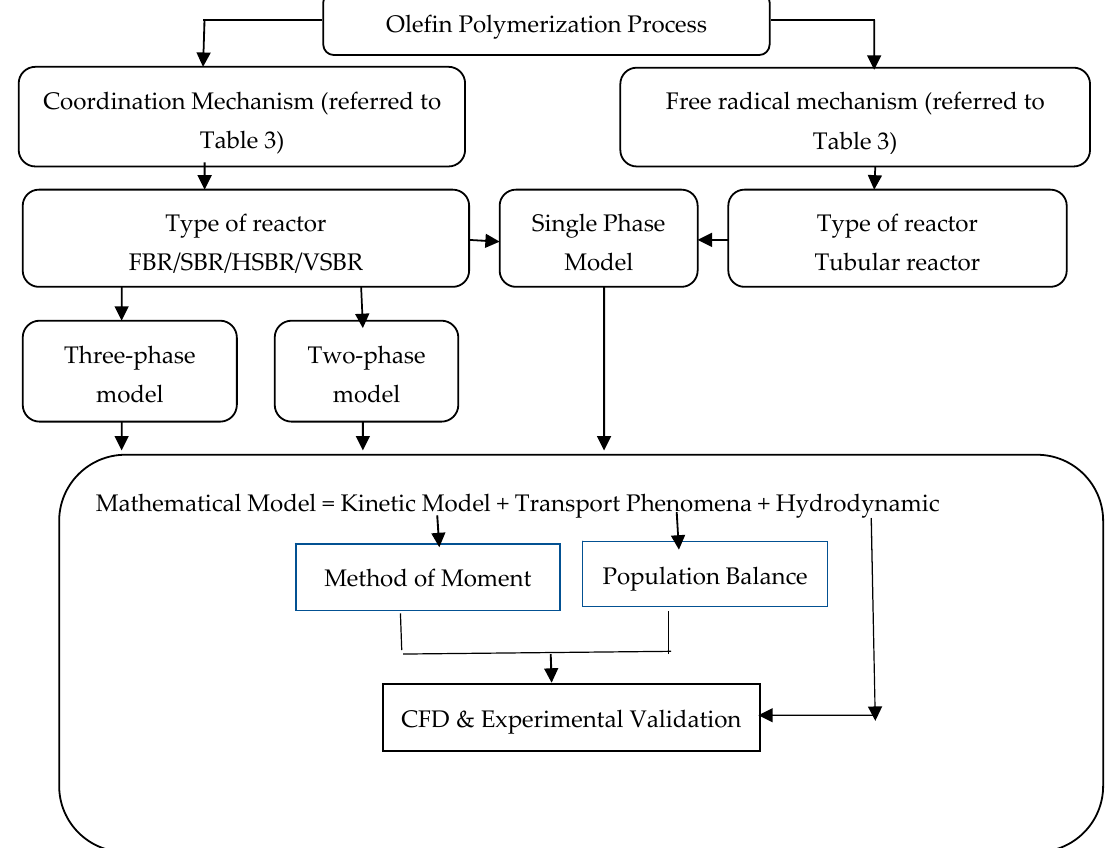
Figure 2. A general flowchart of the guidelines for the implementation of the mathematical model (FBR: fluidized bed reactor; SBR: stirred-bed reactors; HSBR: horizontal-stirred-bed reactor; VSBR: vertical-stirred-bed reactor).